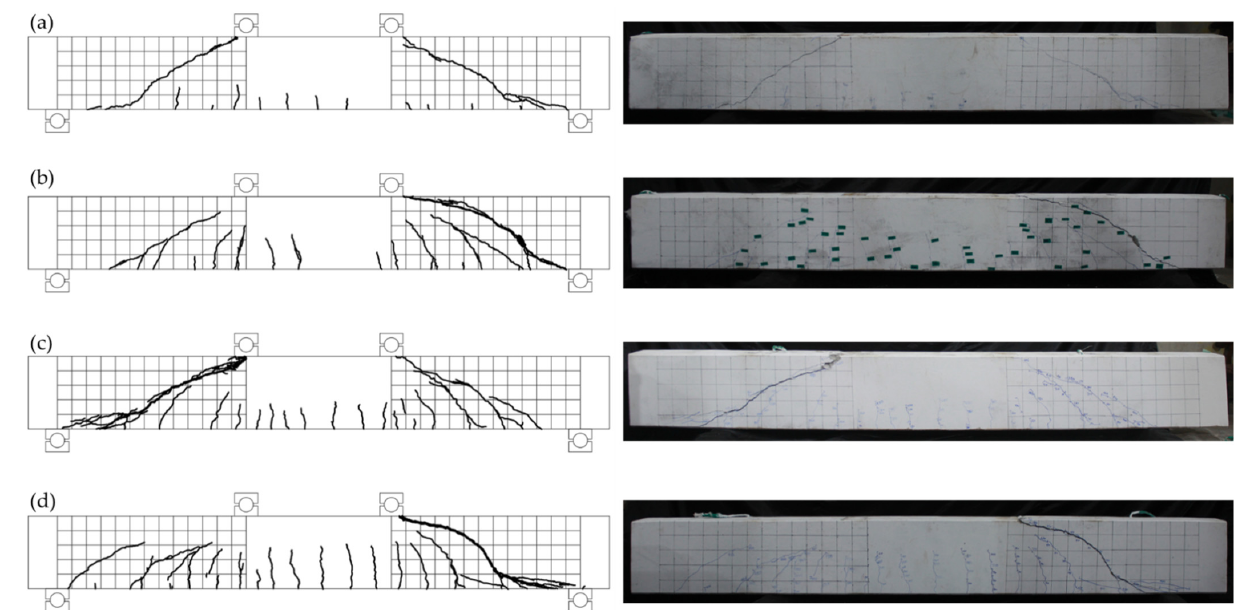
Figure 6. Crack patterns at failure (100-mm unit grid): ( a ) BS-0; ( b ) BS-N; ( c ) BS-2T; ( d ) BS-2.5T.